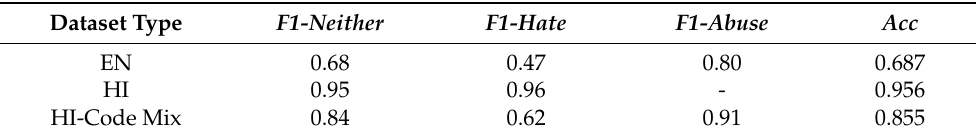
Table 4. Performance Comparison of F1 scores and accuracy between classes for Logistic regres- sion